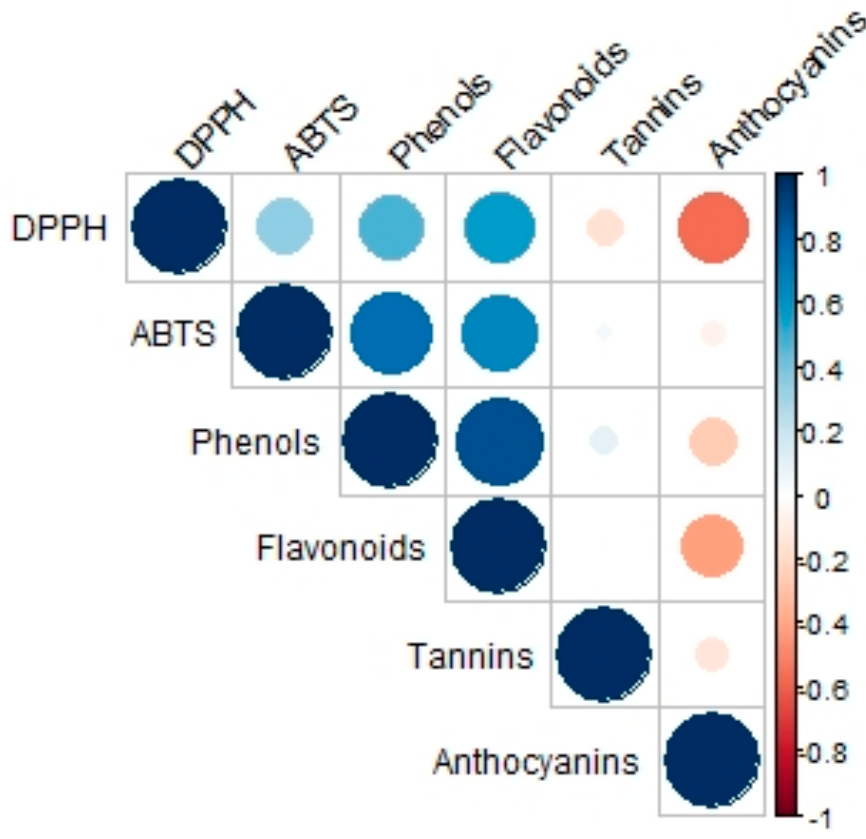
Figure 2. Analysis of Pearson correlation between the content of the components analyzed in the Tepary bean leaf ( Phaseolus acutifolius ). The compounds analyzed in the correlation are 2,2-diphenyl-1- picrylhydrazil (DPPH), (2,2 (cid:48) -azino-bis(3-ethylbenzothiazoline-6-sulfonic acid) (ABTS), total phenols, tannins and anthocyanins. Blue color indicates a correlation close to 1; red color indicates a correlation close to − 1. The size of the circle and the intensity of color indicates the correlation between the two variables; the color gradient from blue to red indicates the extent to which they are proportional or inversely proportional to each other, respectively. All tests were performed in triplicate. Table 5. Antioxidant capacity of the Tepary bean leaf ( Phaseolus acutifolius ) by the DPPH and ABTS methods.